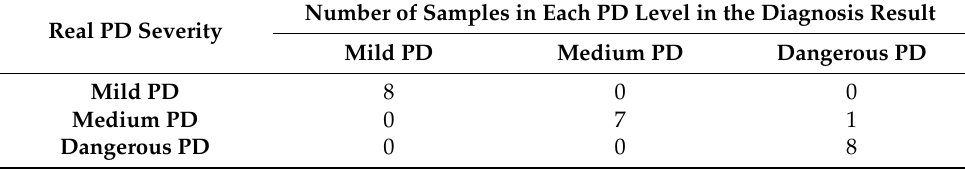
Table 7. Confusion matrix of the diagnosis result based on the support vector machine